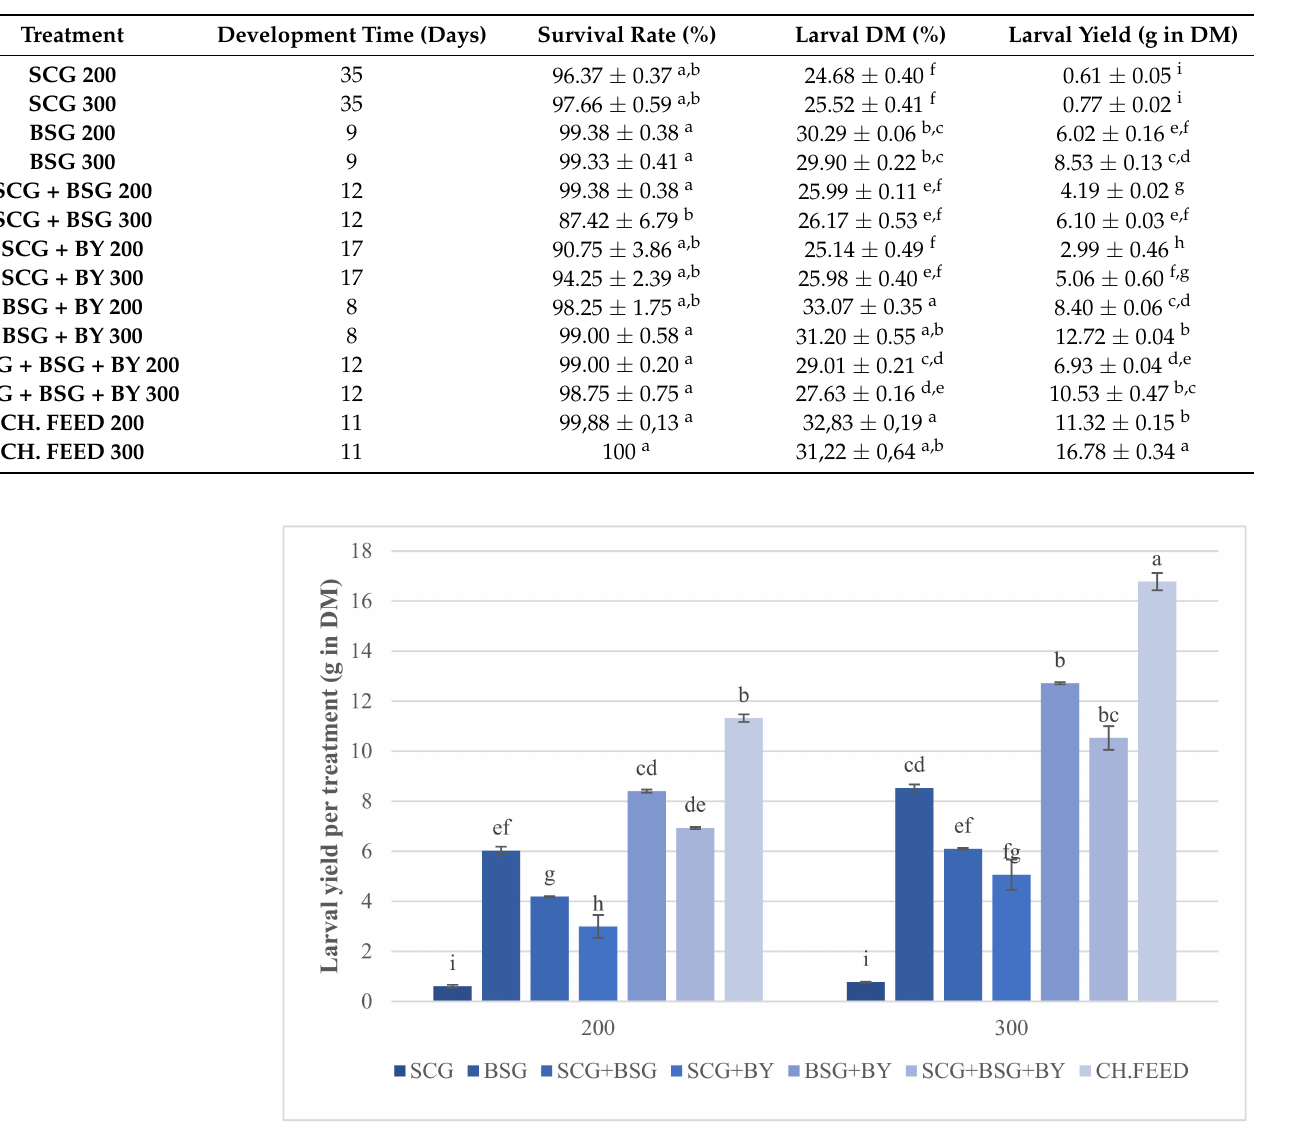
Table 2. Development time, survival rate, dry matter (DM%) and larval yield (g in DM) of larvae reared on spent coffee ground (SCG), brewer’s spent grains (BSG), brewer’s yeast (BY) and their mixtures (mean ± standard error n = 4). Mean values followed by different letters in the same column vary significantly ( p < 0.05).